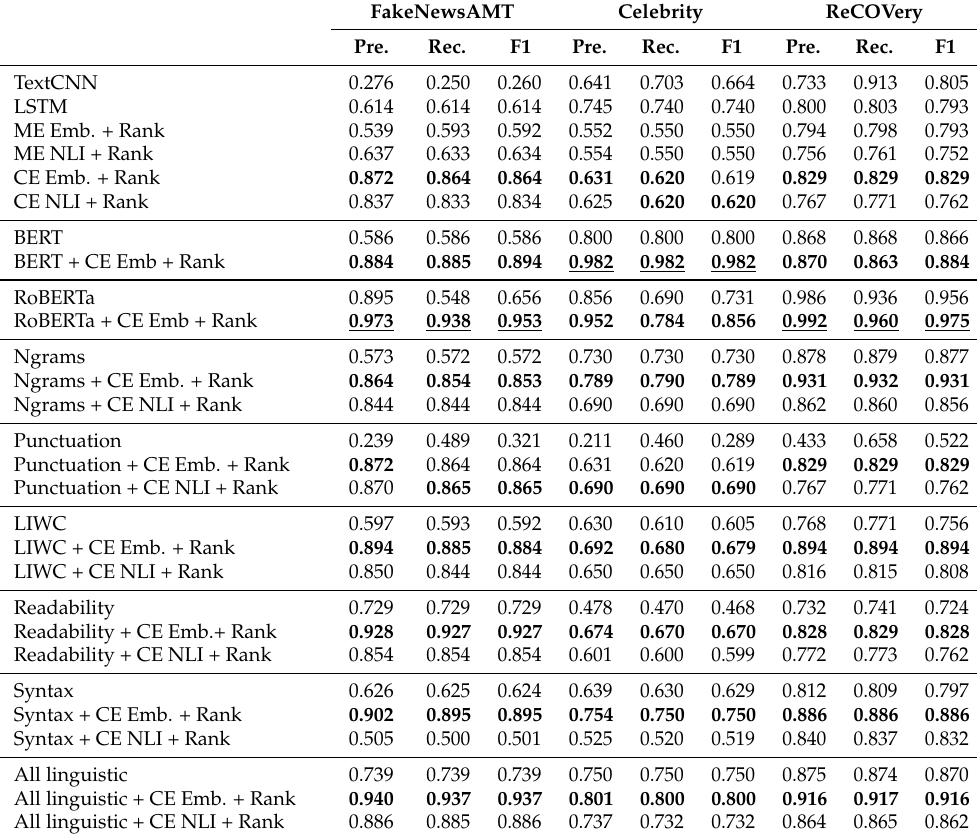
Table 5. Results of the integration of the cross-lingual evidence (CE) feature into automated fake news classification systems. The proposed feature is used in two ways based on the content similarity computation strategy: (i) based on text embeddings (Emb.); (ii) based on NLI scores (NLI). It is also combined with the rank of the news article source (Rank). The CE feature along already showed the results better then the baseline methods. However, in combination with linguistic features, the SOTA results were achieved. The bold numbers indicates the best results in the block, the bold and underlined —the best result for the dataset. All improvements in the results were statistically proven by the t -test on the 5-fold